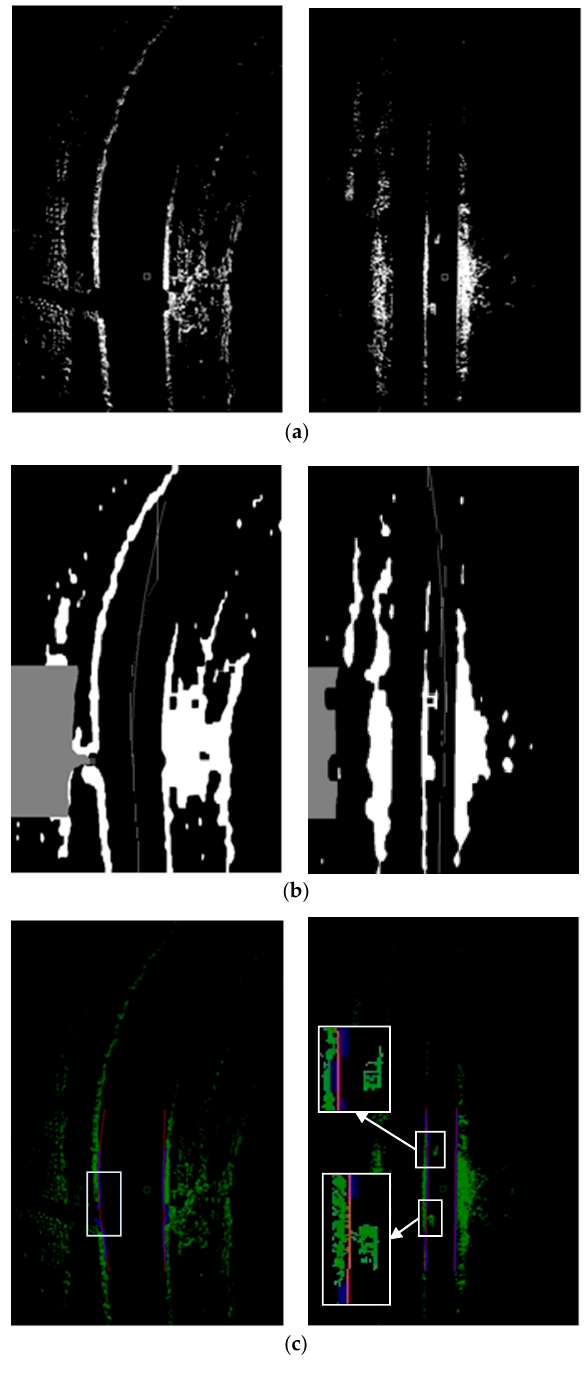
Figure 17. Result of the region growing and curve fitting. ( a ) Obstacle map; ( b ) Width distribution; ( c ) Curve fitting result.